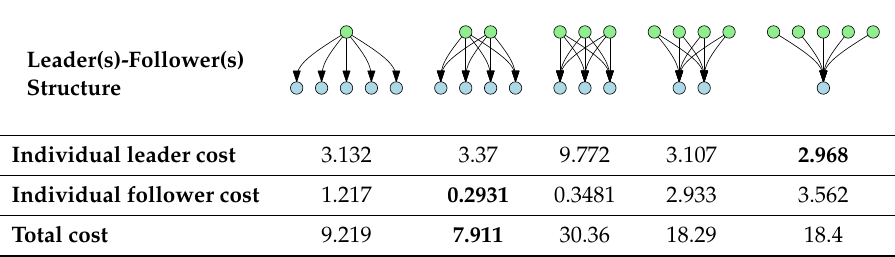
Table 1. Summary of ¯ α leader homogeneous scenario. bold—significant